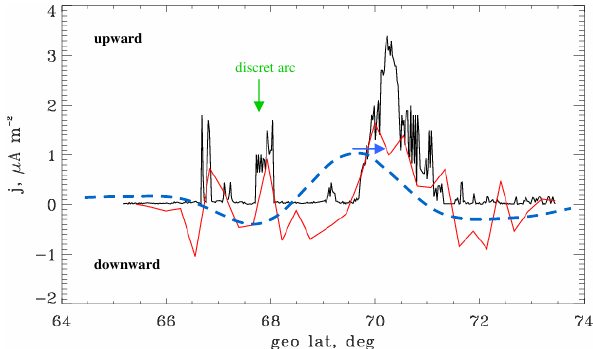
Fig. 3. Field-aligned currents along the Demeter orbit as deduced from the ground magnetic measurements (blue dashed line), from the onboard magnetic (red line) and particle (black line) observa- tions. Positive/negative sign stands for upward/downward current. Note that sensitivity of onboard fluxgate magnetometer is ∼